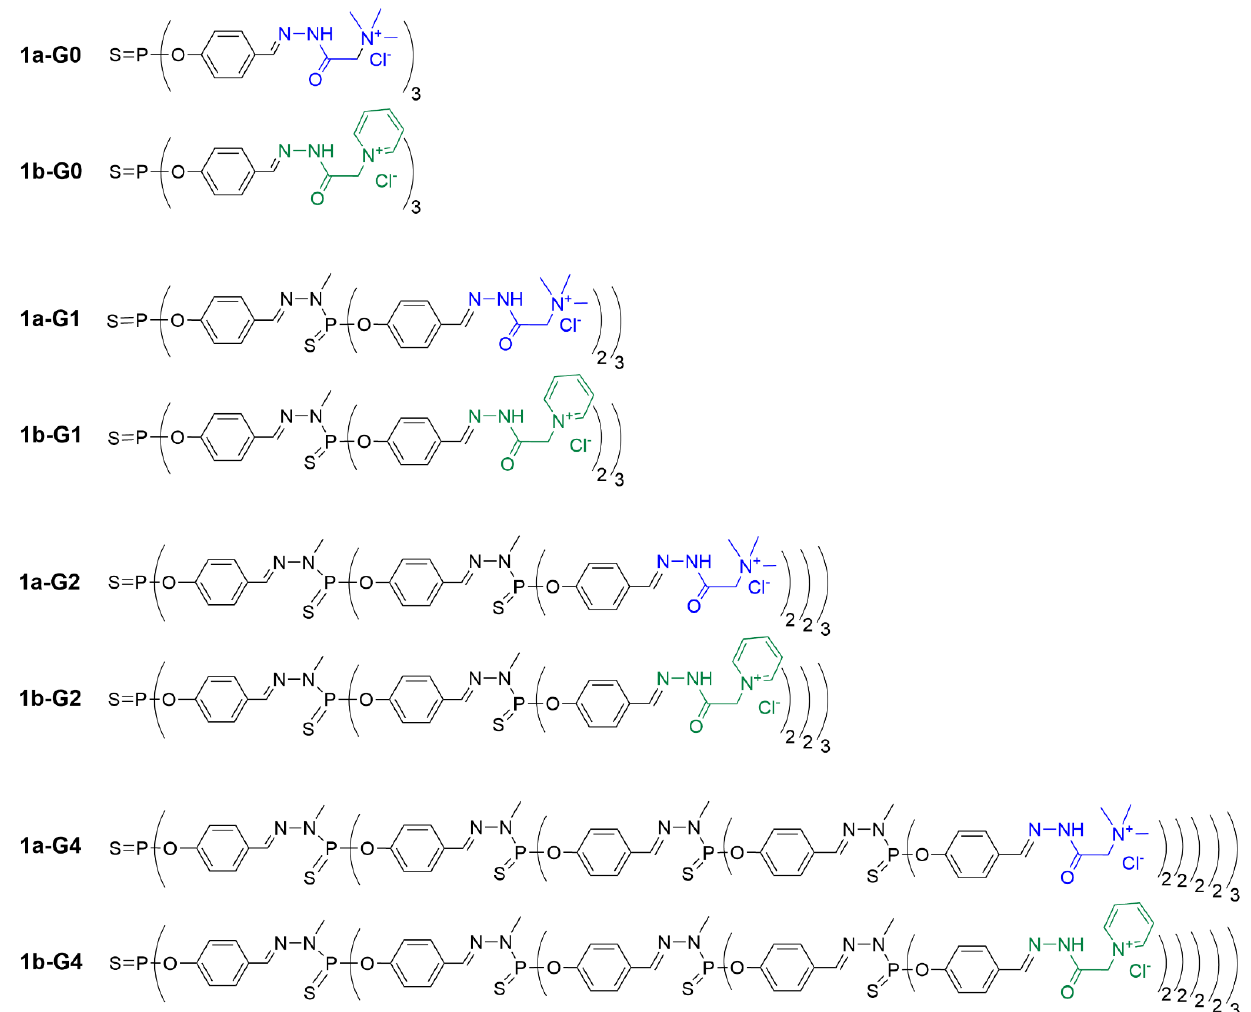
Figure 3. Linear representation of the chemical structure of phosphorus dendrimers built from a trifunctional core and functionalized with the Girard T reagent (series a , in blue) or the Girard P reagent (series b , in green) as hydrophilic terminal functions.